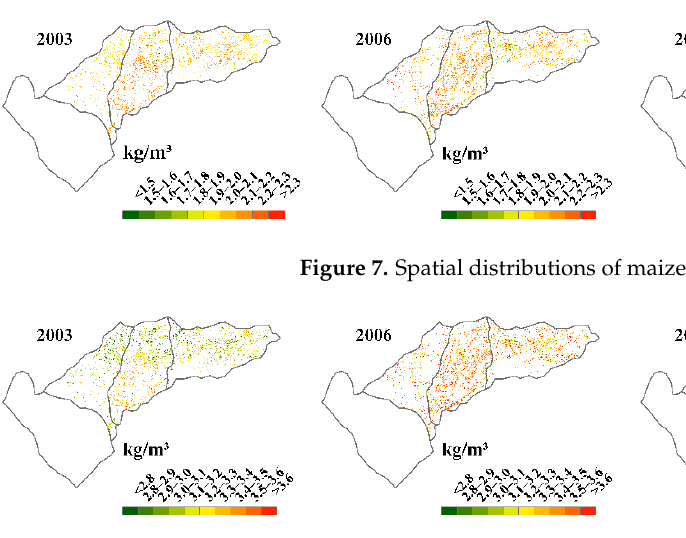
Figure 8. Spatial distributions of maize WUE T from 2003 to 2012.